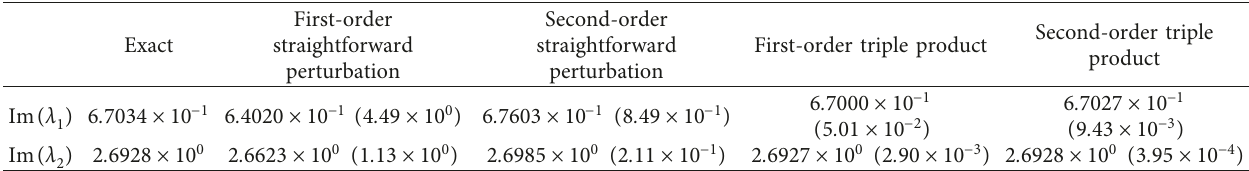
Table 4: The imaginary parts of the exact and approximate natural frequencies for the perturbed two-degree-of-freedom gyroscopic system of Figure 5 for σ � 0 .